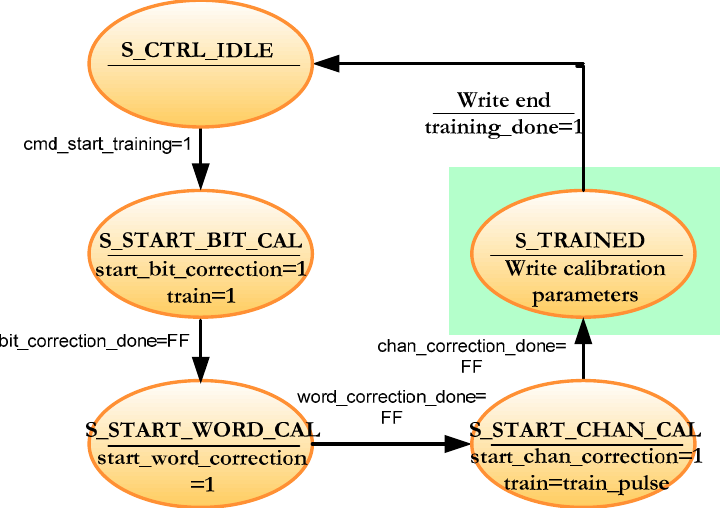
Figure 13. Simplified FSM for the overall calibration system in the concurrent architecture.